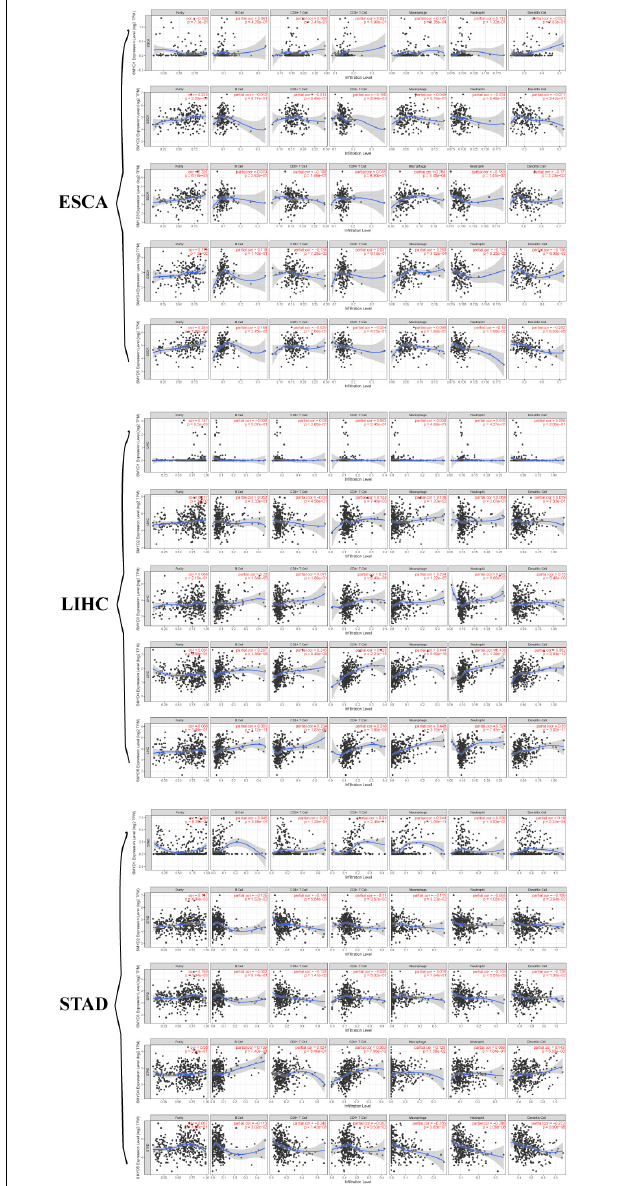
FIGURE 7 | Correlation between SMYD members and immune cell infiltration, X -axis is SMYD members, Y -axis is immune infiltrates, P -value greater than 0 is positive correlation, P -value less than 0 is negative correlation. (Timer) ( P < 0.05, with statistical significance).